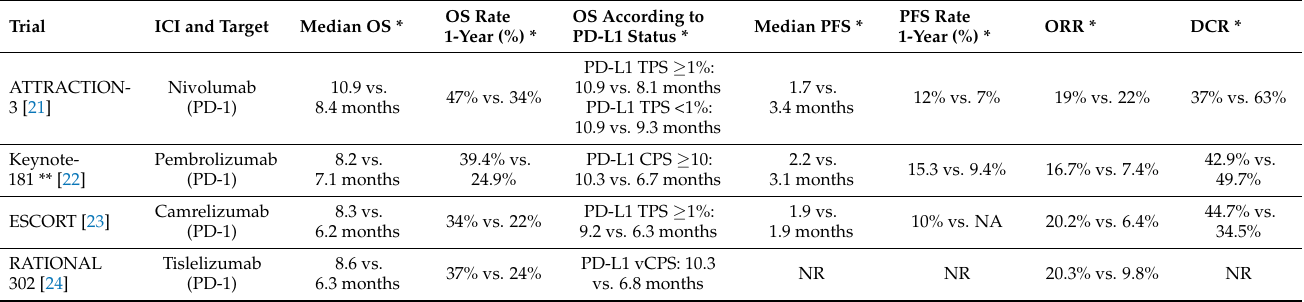
Table 3. Outcomes indirect comparison between immune checkpoint inhibitors in the second-line setting for metastatic oesophageal squamous cell